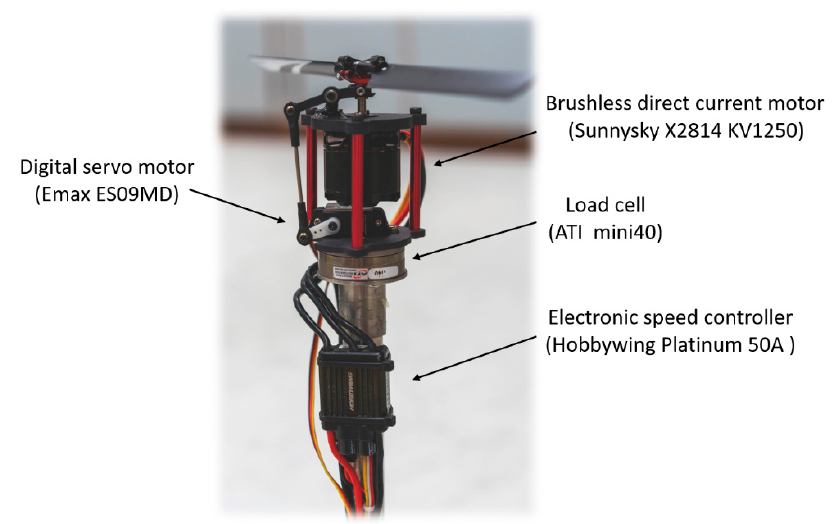
Figure 3. The set-up of the static thrust experiments.